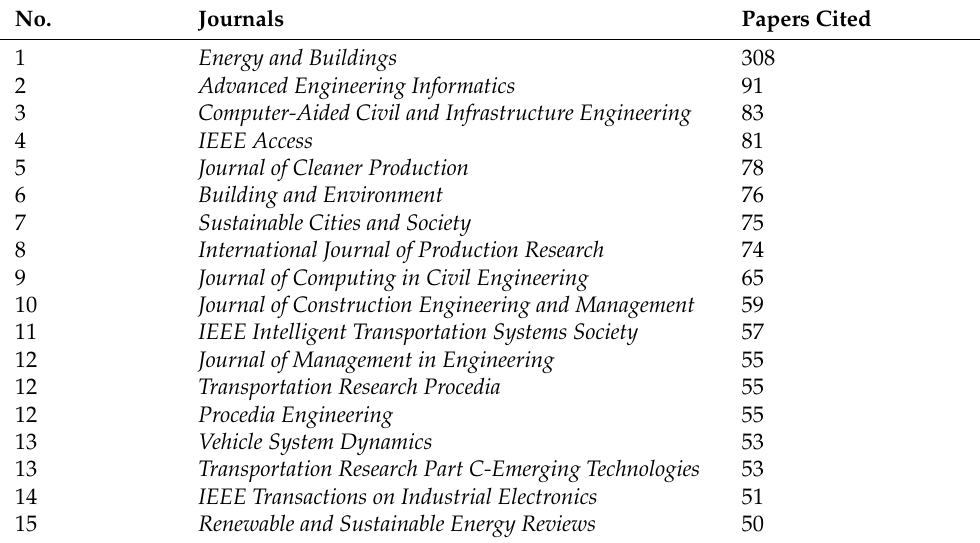
Table 4. Most Locally Cited Sources in the WoS and Scopus (from Reference